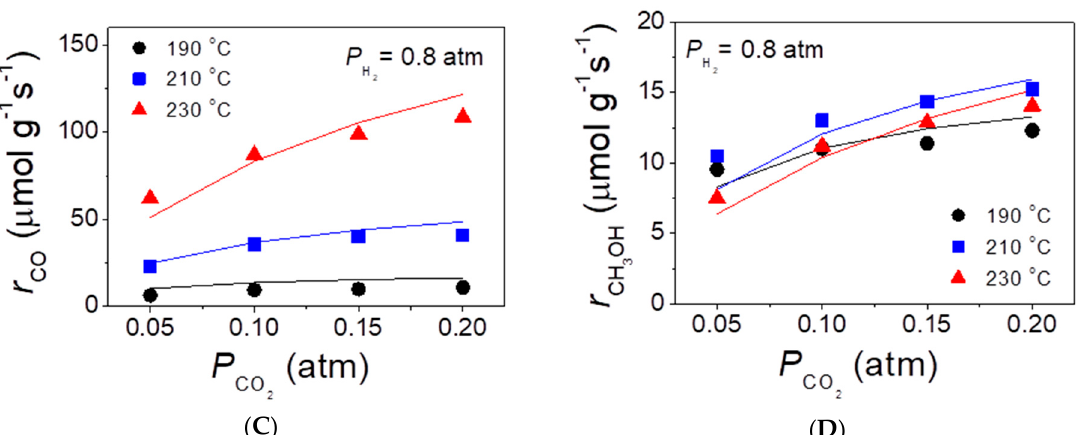
Figure 6. Effects of the partial pressure of H 2 in the feed at the constant partial pressure of CO 2 ( A , B ) and of the partial pressure of CO 2 at constant partial pressure of H 2 ( C , D ) on the rates of CO ( A , C ) and methanol ( B , D ) evolution at temperatures of 190, 210, and 230 °C. Solid lines correspond to fitting of experimental results (symbols) with the use of the kinetic model described in Section 3.2.